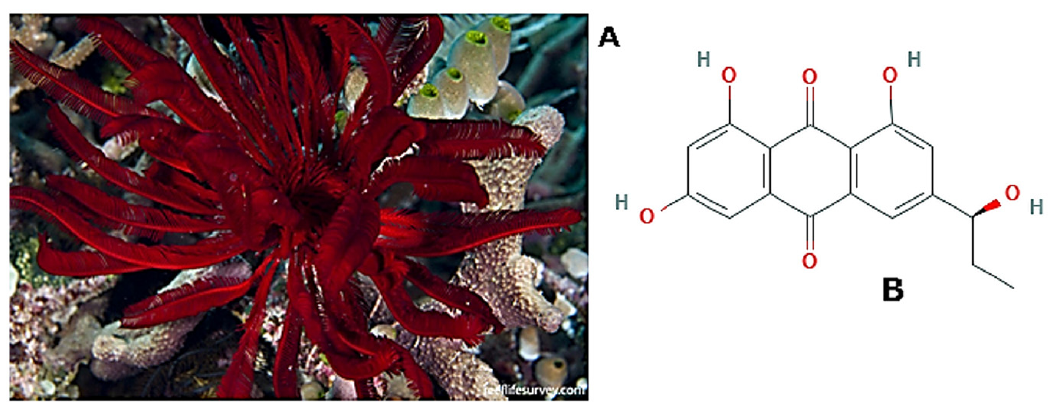
Figure 24. ( A ) An individual of Himerometra magnipinna . © Andrew Green; https: // reeflifesurvey.com / . Figure 24. A ) An individual of Himerometra magnipinna . © Andrew Green; ( B ) 2D structure of rhodoptilometrin; https: // pubchem.ncbi.nlm.nih.gov / compound / Rhodoptilometrin# https://reeflifesurvey.com/. B ) 2D structure of rhodoptilometrin; section = https://pubchem.ncbi.nlm.nih.gov/ compound/ Rhodoptilometrin#section=2D-Structure.